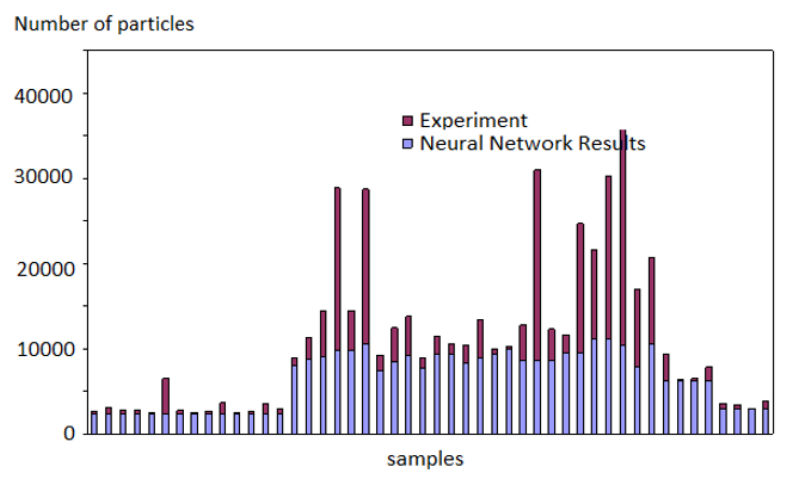
Fig. 2. Results of modeling the process of wear of a thin-film